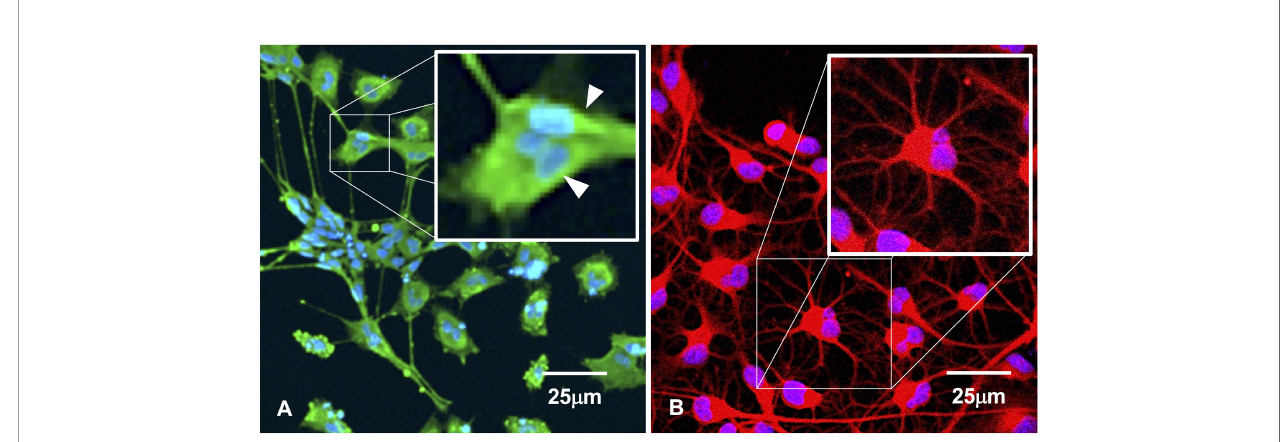
FIGURE 5 | Immuno fl uorescence suggests syncytia. (A) HHV-6A infection in HNSC results in syncytia formation as indicated by cell membrane fusion and multi- nucleated cells (arrows). (B) Uninfected culture shows individual well-bounded dHNSC membranes and the absence of any cell aggregation that would suggest syncytia-like formations. [Scale bar = 25